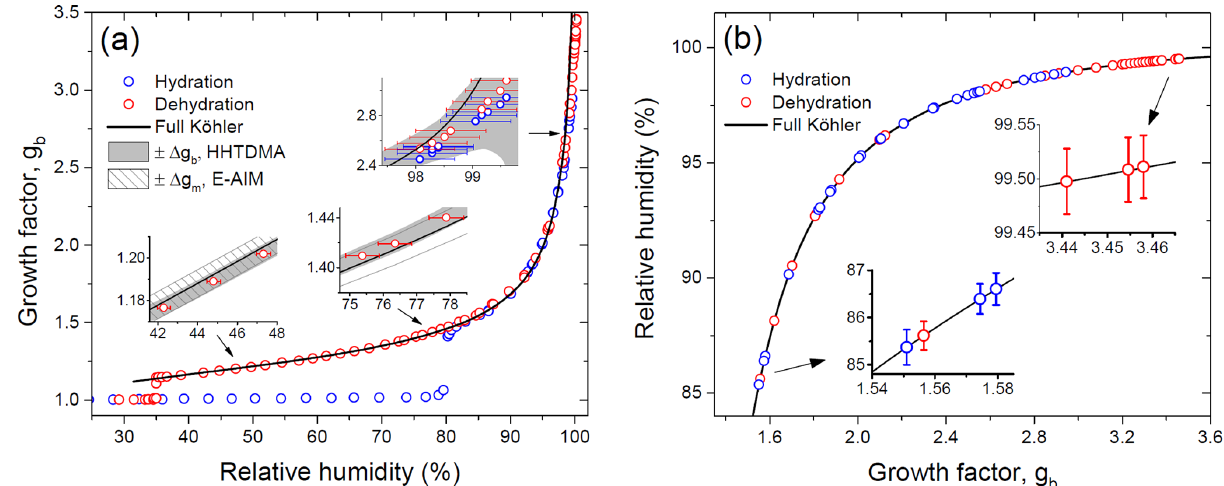
Figure 8. Growth factors observed in the hydration and dehydration experiments for the preconditioned ammonium sulfate aerosol particles with D b, H&D , min = 79 . 6nm compared with the full Köhler model: (a) growth factors as a function of relative humidity measured with a capacitive RH probe (RH4; Fig. 1); (b) RH values obtained from E-AIM using experimental growth factors. Insets in panel (a) : the gray area denotes the growth factor uncertainty obtained from Eq. (2); the shaded area corresponds to the growth factor uncertainty of E-AIM below the DRH obtained from EDB experimental data. Whiskers show RH uncertainty (a, b) .